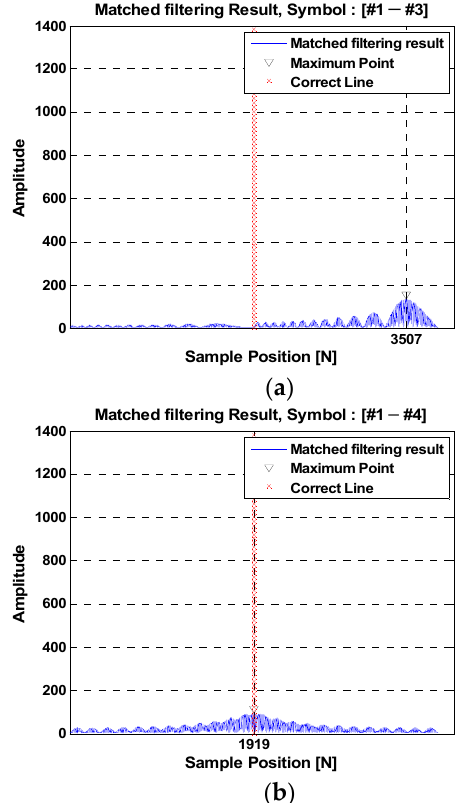
Figure 4. Matched filter output in different frequency bands. ( a ) The same slope symbol; ( b ) different slope symbols.